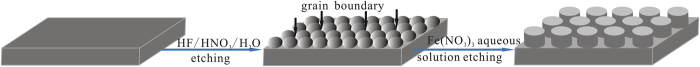
Schematic view of preparing porous Ag surface on the silver plated aluminum alloy sample by wet chemical etching.